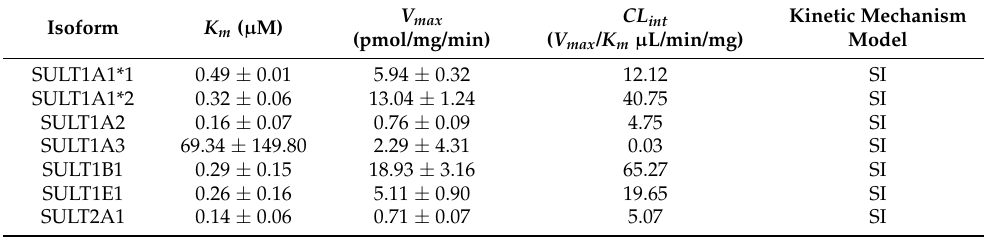
Figure 5. Enzyme kinetic analysis for the activities of the seven recombinants human SULT isoforms ( A – G ) through the magnolol substrate. Results obtained were analyzed using GraphPad Prism 7.0 software. In each figure, the inset shows the Eade–Hofstee plot. Each point is the average of three determinations, and the error bar is the standard deviation of the mean. Table 3. Summarized enzyme kinetic parameters of seven human recombinant SULT isoforms with magnolol as the substrate. SI stands for the substrate inhibition model. Data represents the mean ± standard deviation derived from three